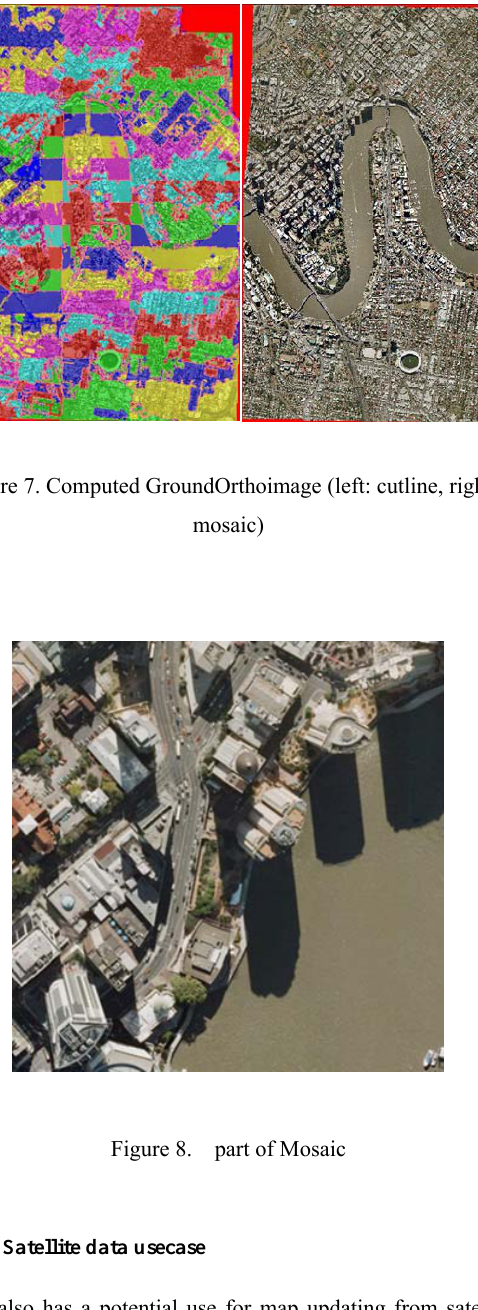
Figure 8. part of Mosaic 2 Satellite data usecase 5. SGM also has a potential use for map updating from satellite images as similar to the workflow as Aerial dataset.